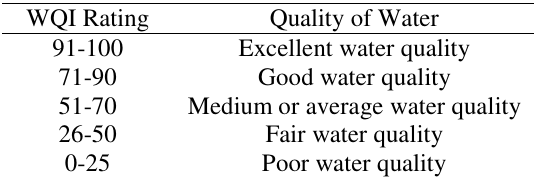
Table 2. Average WQI rating of groundwater sources in different season.